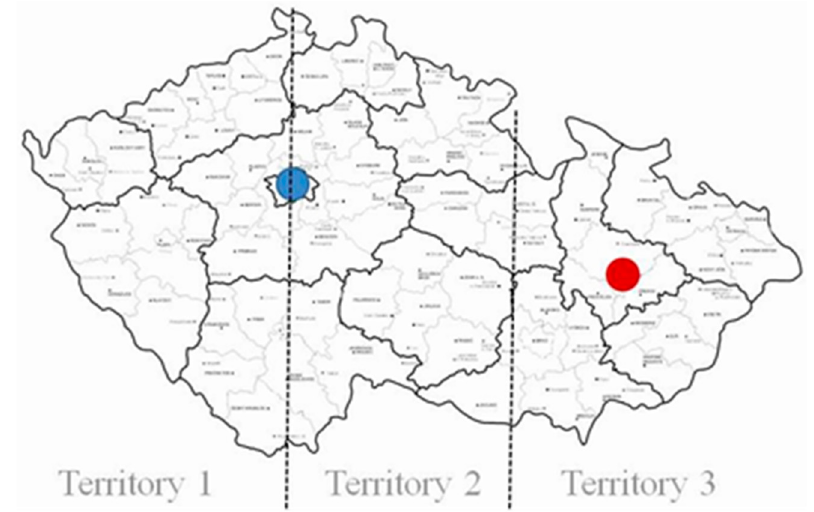
Figure 2. Map of the territorial division.